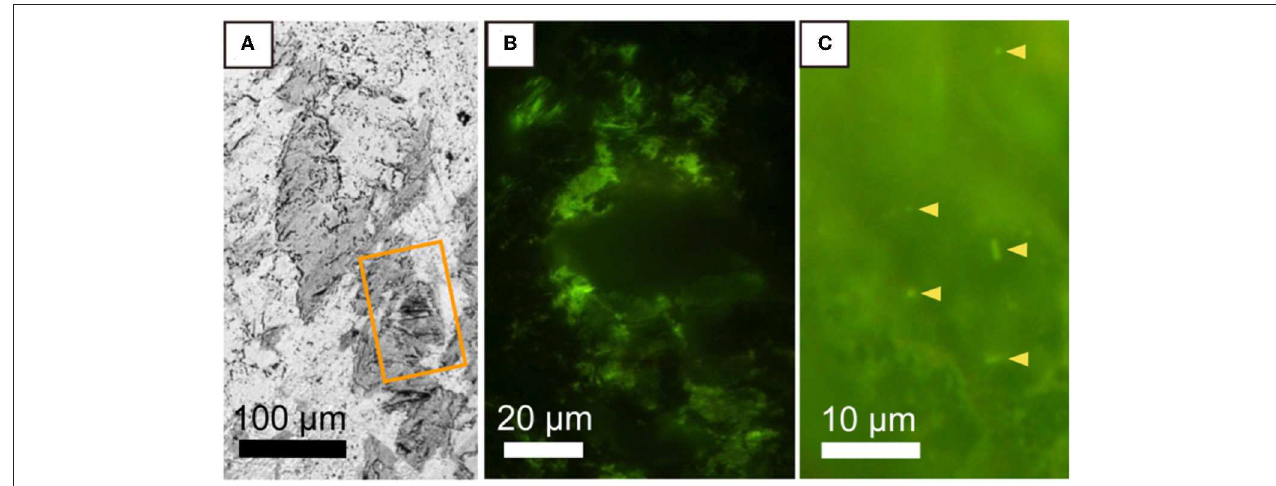
FIGURE 4 | Microbial distribution in a saponite-bearing locus near basaltic groundmass revealed by staining of a thin section with SYBR-Green I. (A) Back-scattered electron image of saponite aggregates enlarged from Figure 2B . An orange rectangle indicates the area shown in (B) . Fluorescence microscopy images of SYBR Green I-stained microbial cells associated with saponite in a 100- µ m thin section of a rock piece (B) and in a 3- µ m thin section of a clay fraction (C)